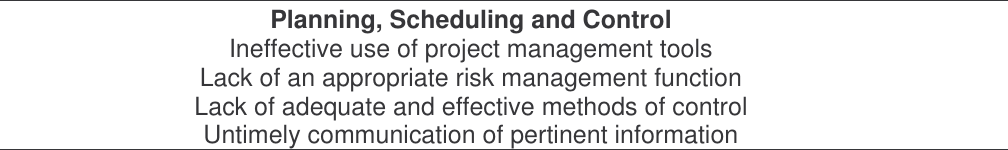
Figure 2: Problems of Project Management in Ghana